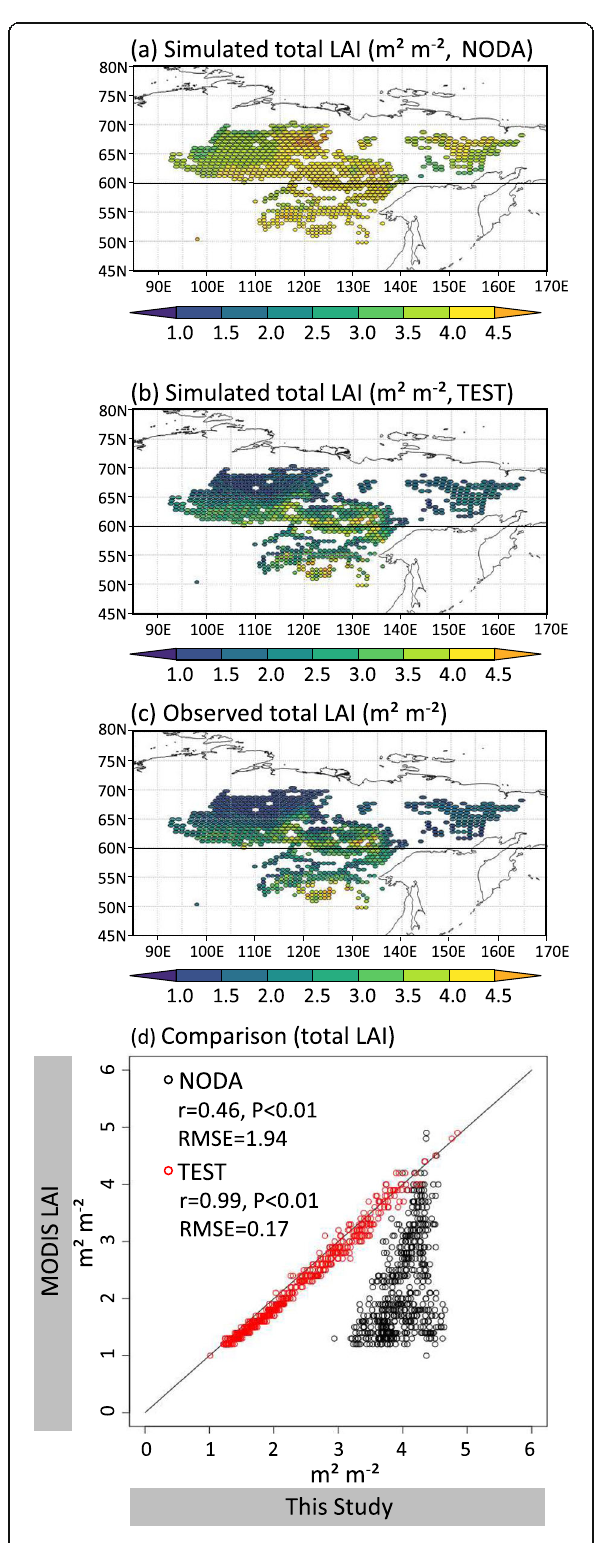
Fig. 3 Total LAI (annual maximum of median). a NODA, b TEST, c observation, and d scatter plot of simulation results (NODA and TEST) against observational data. The estimates for sites south of 60° N were not stable. Only results from sites north of 60° N (latitude line shown in each map) were used in subsequent scatter plots